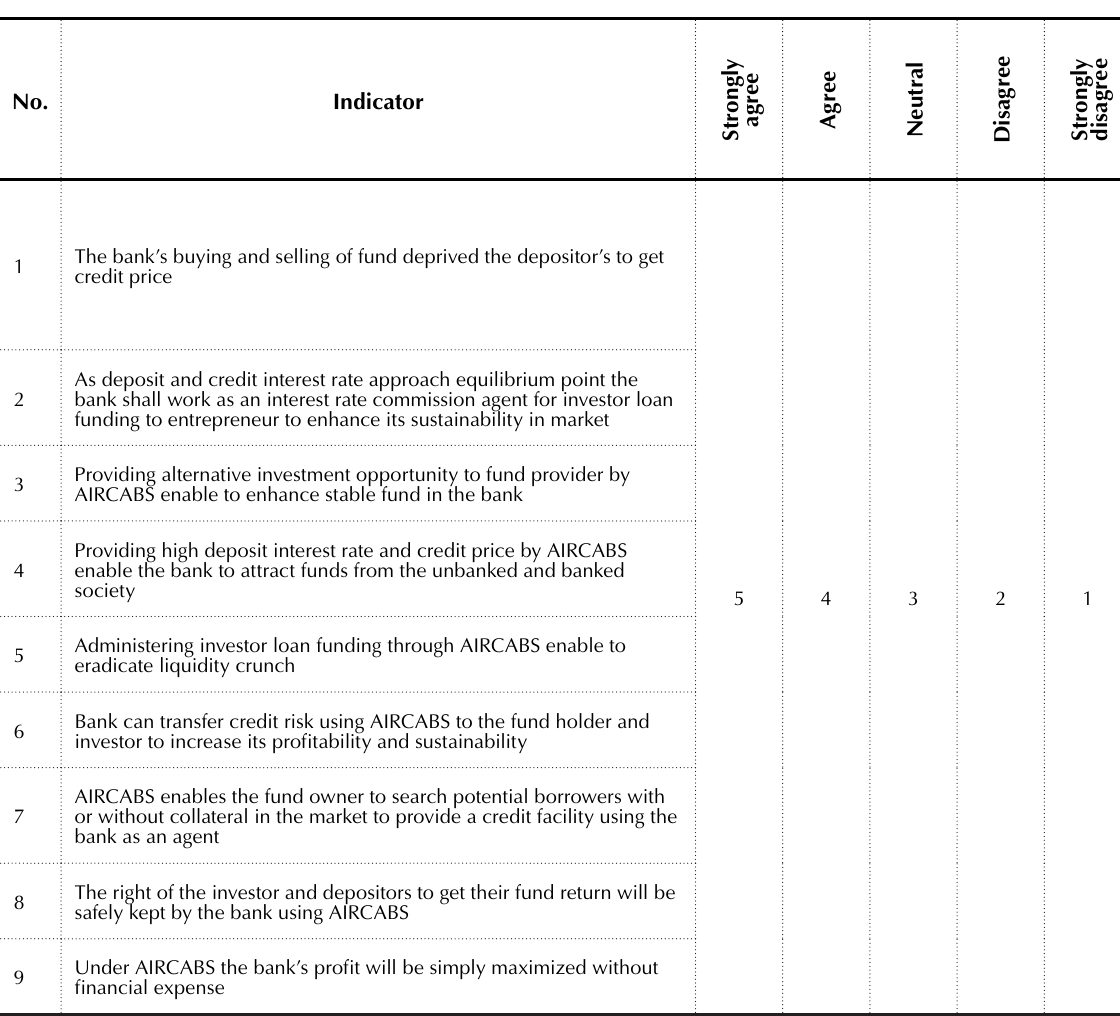
Table 4. Indicators of AIRCABS